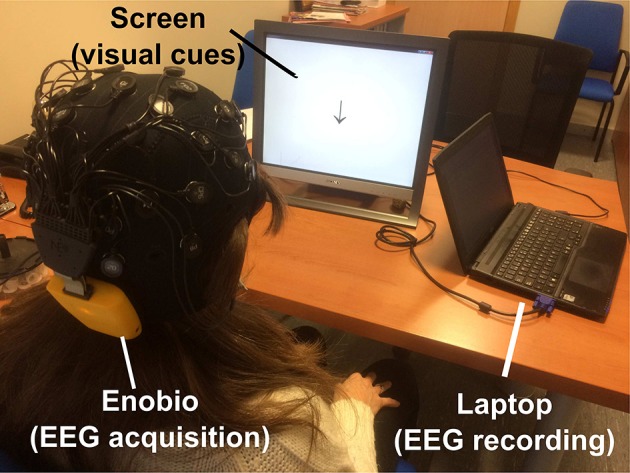
Experimental setup.